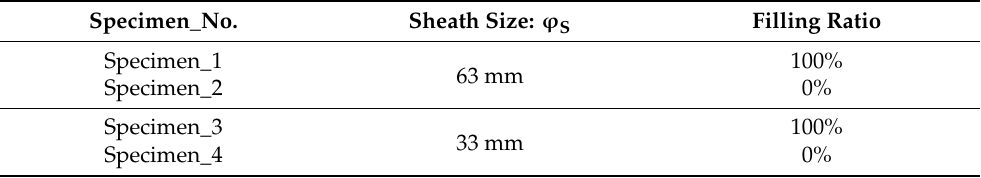
Table 2. Sheath Table 2. Sheath conditions.